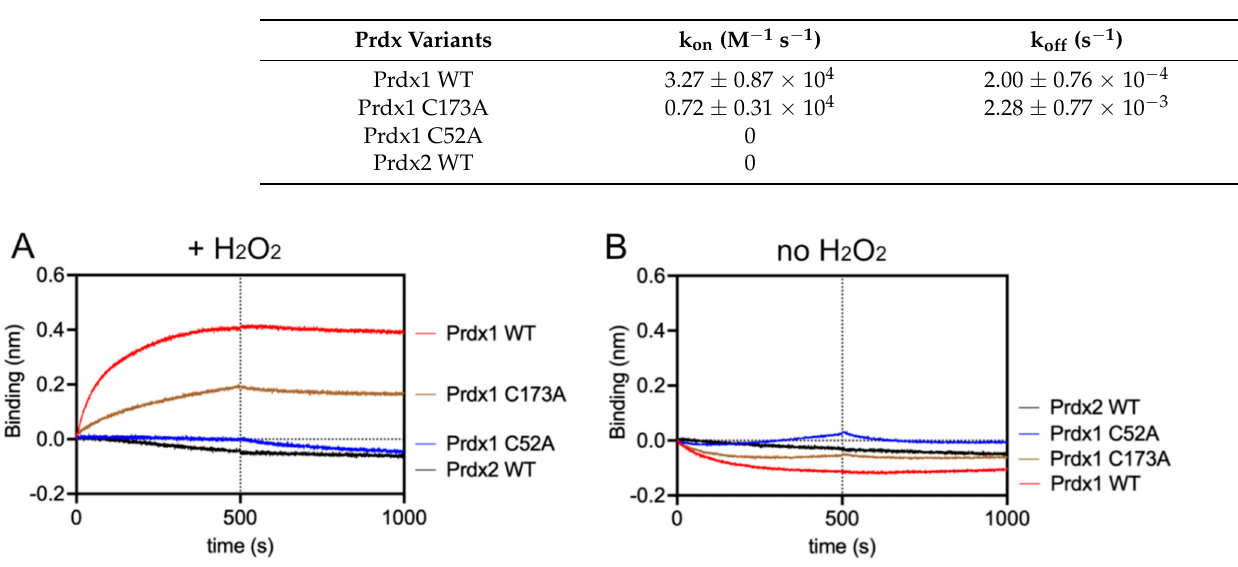
Table 3. The rate constants for the interaction of Prdx variants with ASK1-TBD showed a peroxidatic cysteine-dependent fast reaction and the formation of a stable bond, suggesting a Prdx1-ASK1-TBD mixed disulfide.